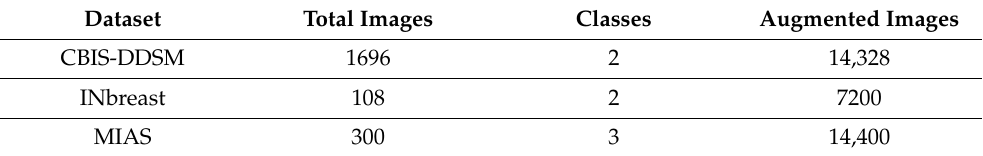
Table 1. Dataset